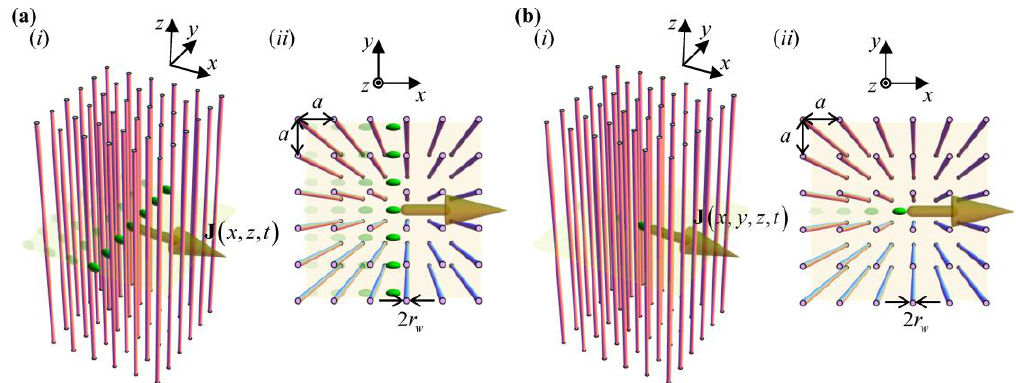
Figure 1. Illustration of the systems under study: charged particles moving along the x -direction with a constant velocity v , inside an unbounded wire medium formed by metallic wires embedded in vacuum. ( a ) A linear array of charged particles; ( b ) a single charged particle. The wires have radius r and are arranged in a square lattice with lattice w constant a